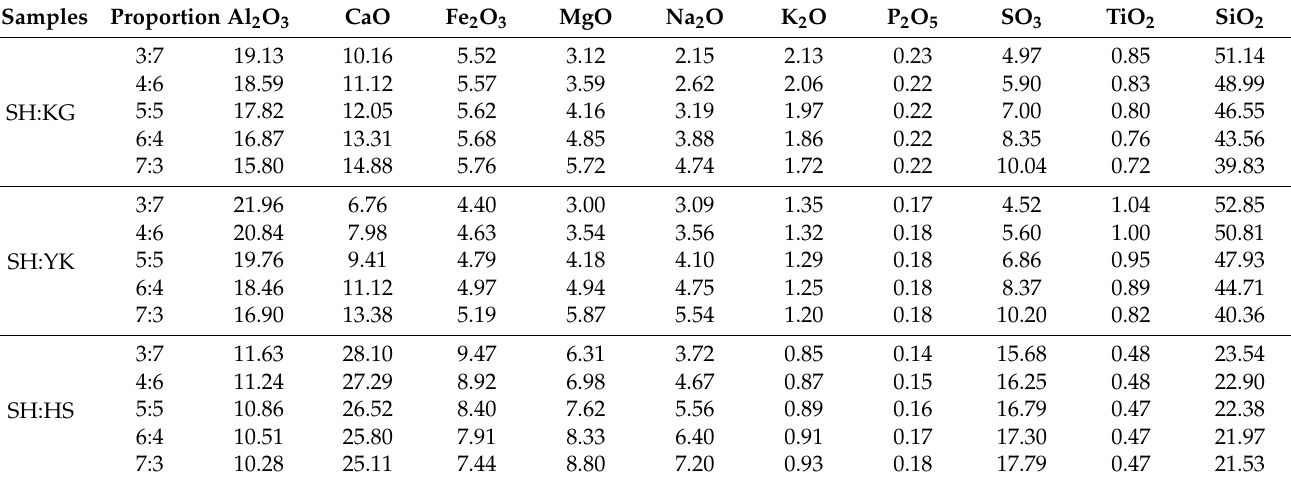
Table 5. Ash compositions of the blended coals